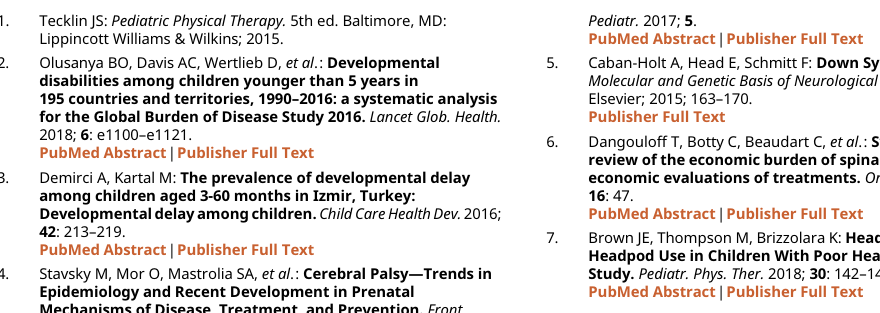
- Data file 2 (Appendix 1 is the figure illustrating the Conceptual Framework mapping the physiotherapy and technology-based interventions in children with Developmental Disabilities) - Data file 3 (Appendix 2 is the preliminary PubMed search strategy carried out on